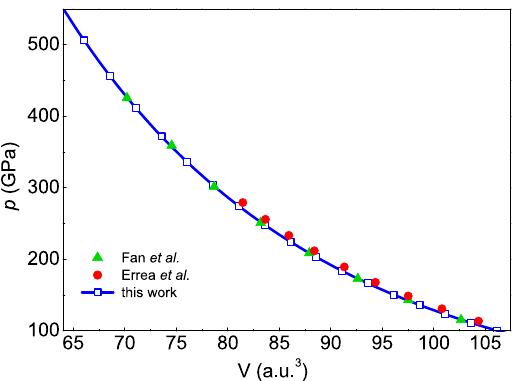
Figure 2. The calculated volume-pressure data in the classical nuclei limit (the equation of states). The filled symbols are related to the results presented in publications 39, 56